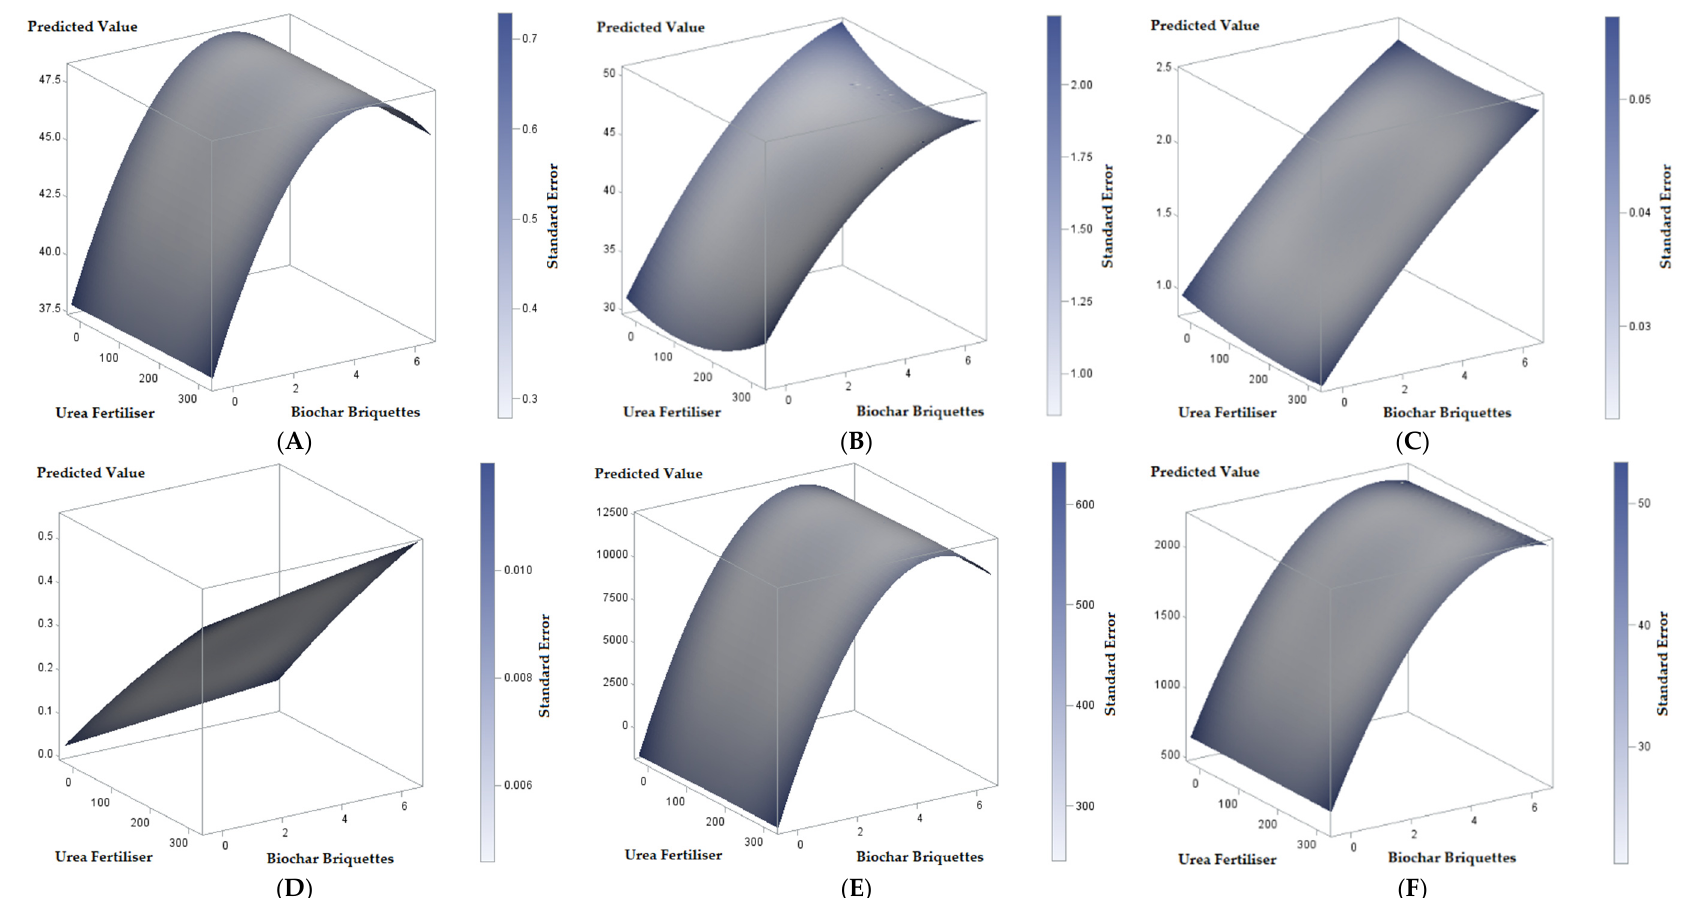
Figure 3. The response of soil properties to in situ biochar briquettes (grain plant − 1 ) and urea fertiliser (kg ha − 1 ). ( A ) Water-holding capacity (%), ( B ) Total porosity (%), ( C ) Soil organic carbon in the soil after harvesting (%), ( D ) Total nitrogen in the soil after harvesting, ( E ) Total fungi in the soil after harvesting (colony g soil dry weight − 1 ), and ( F ) Total bacteria in the soil after harvesting (colony g soil dry weight − 1 ).